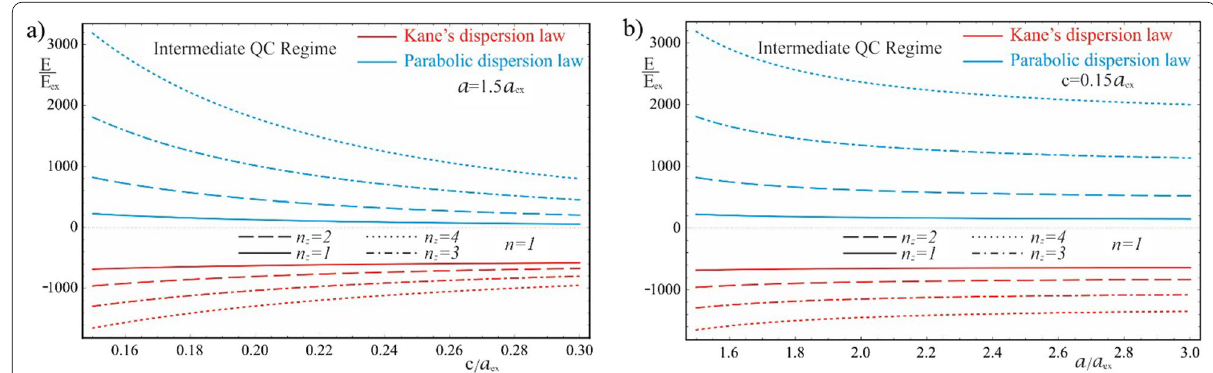
Fig. 11 The dependence of the energy levels of vertical quantization of the motion of the center-of-gravity of a 2D exciton with parabolic and Kane’s dispersion laws of CCs: ( a ) on the minor semiaxis c at the fixed value of the major semiaxis a , ( b ) on the major semiaxis a at the fixed value of the minor semiaxis